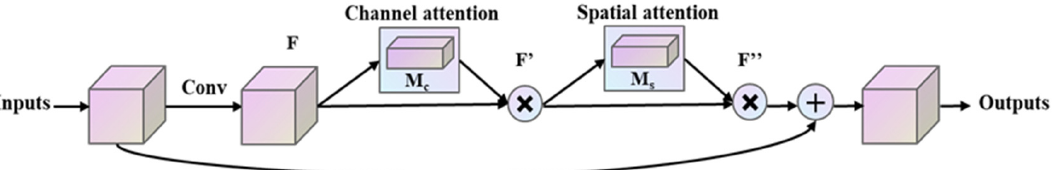
Figure 6. The improved attention submodule (IASM) (structure of serial channel attention and spatial attention).